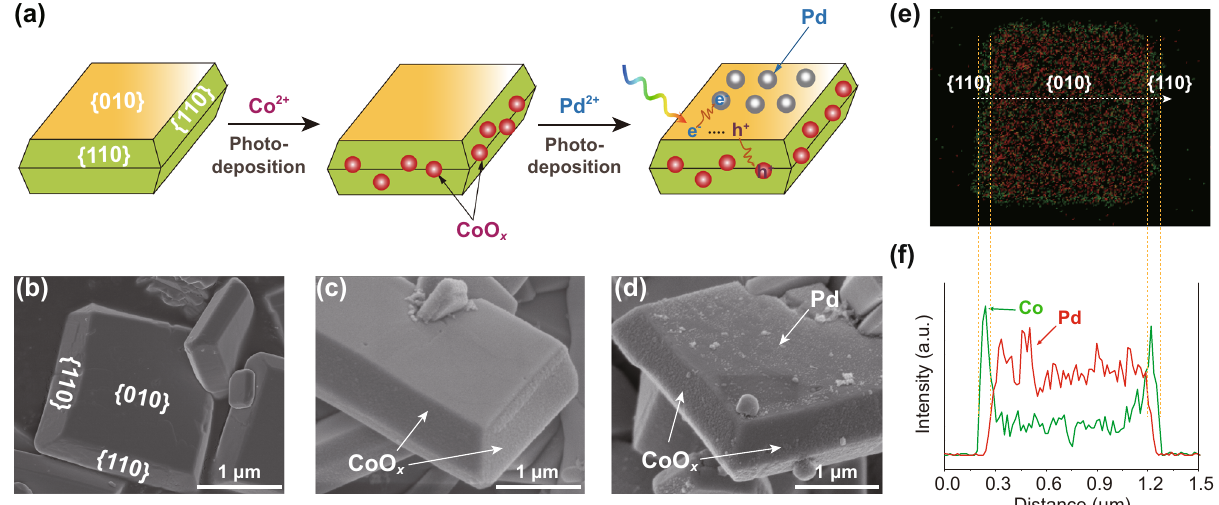
Fig. 1 Facet-selective loading of CoO x and Pd cocatalysts on Mo:BiVO 4 . a Schematic deposition processes of CoO x and Pd on Mo:BiVO 4 and the corresponding SEM images of b Mo:BiVO 4 , c CoO x /Mo:BiVO 4 , and d CoO x /Mo:BiVO 4 /Pd. e , f Energy-dispersive X-ray spectroscopy (EDS) elemental mapping and line pro fi le along with the white arrow of CoO x /Mo:BiVO 4